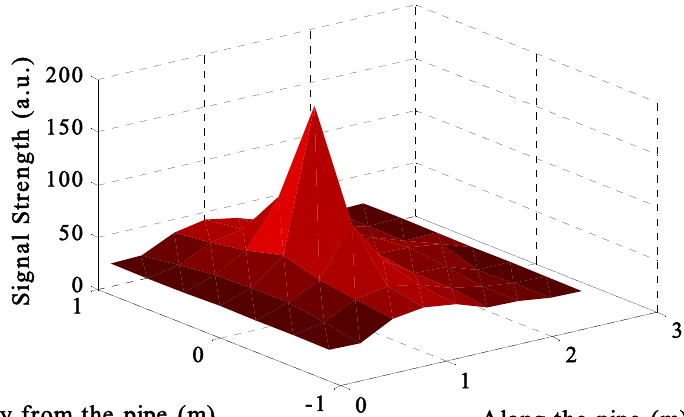
Figure 14. Signal strength detected by the Smart Server whilst